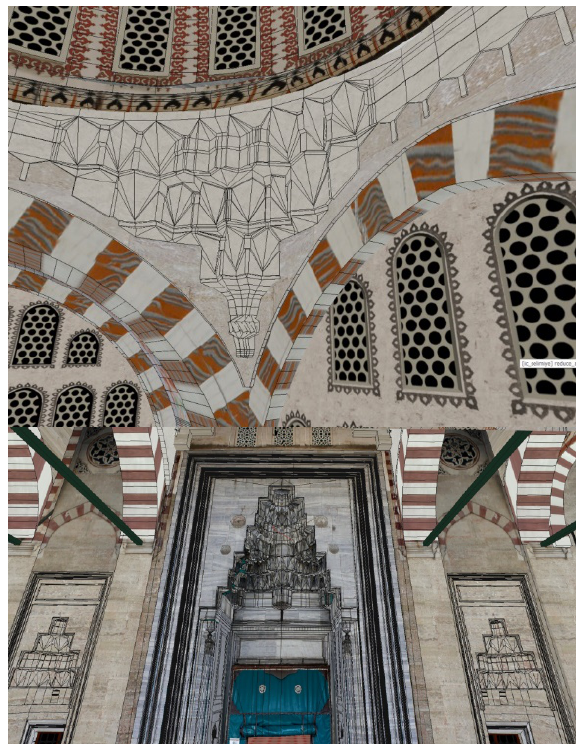
Figure 5. Textured 3D model superimposed with the wireframe